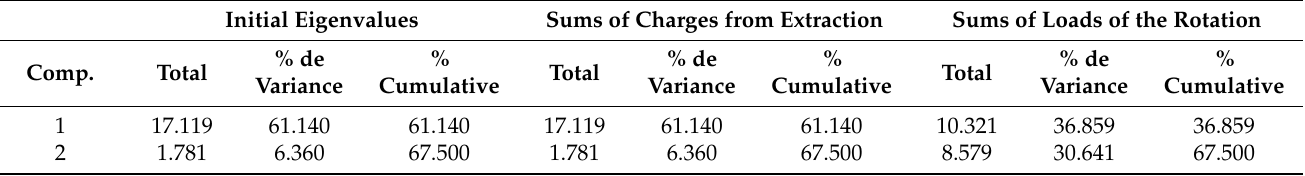
Table 9. Extraction of factors of ethical values in